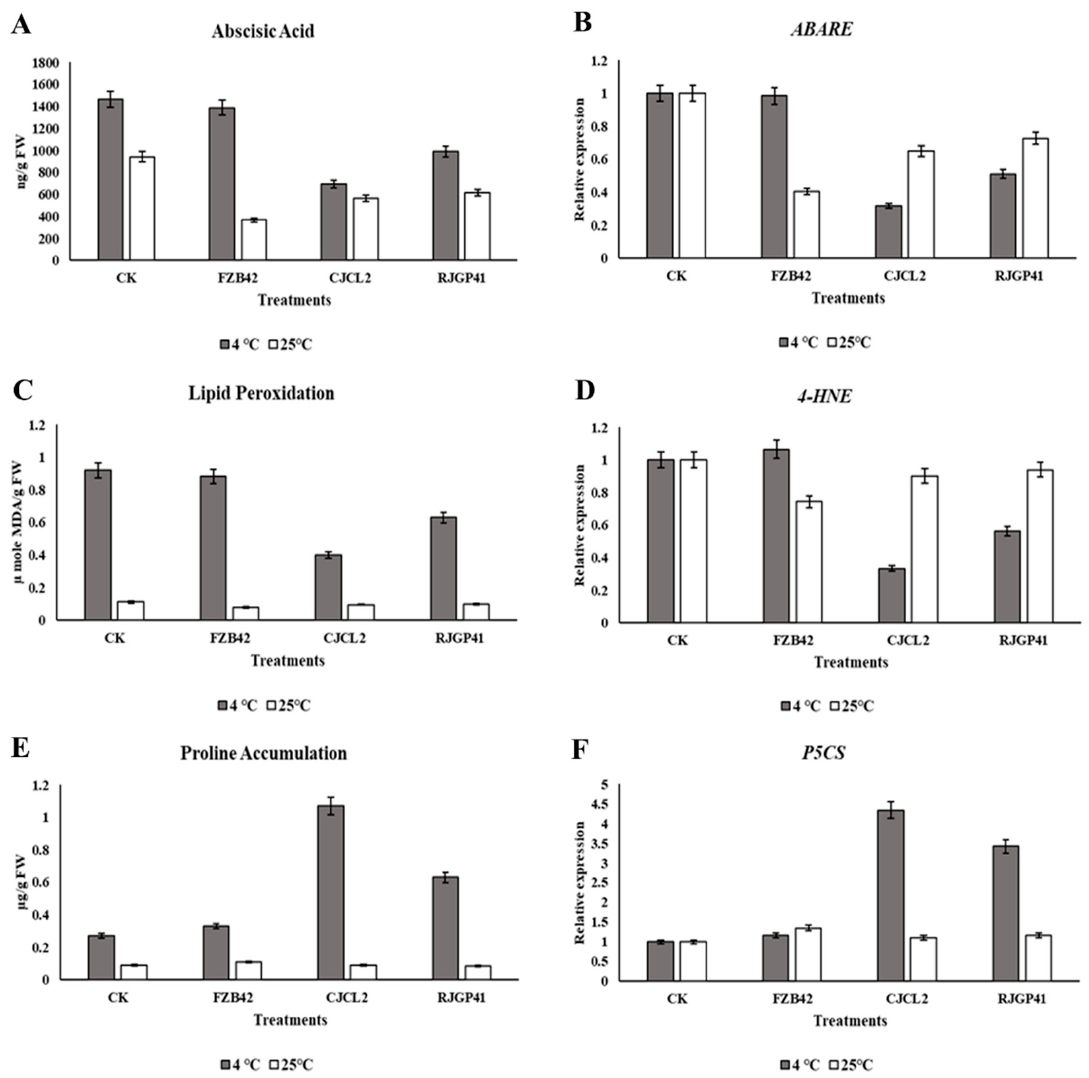
Figure 9. Quantification of abscisic acid by UPLC in wheat plants grown at 4 °C and 25 °C under different bacterial treatments ( A ). Relative expression level abscisic acid (ABA) encoding gene ( ABARE ) ( B ). Spectrophotometric quantification of malondialdehyde (MDA) from wheat plants ( C ). Relative expression level of MDA encoding gene ( 4-HNE ) ( D ). Spectrophotometric quantification of proline ( E ). Relative expression level of ARF gene encoding proline synthesis ( F ). The error bars represent the standard deviation of the mean ( n = 3). The significant difference was observed for all treatments by using Tukey’s HSD test at p ≤ 0.05 and the experiment was repeated in triplicate with similar results.